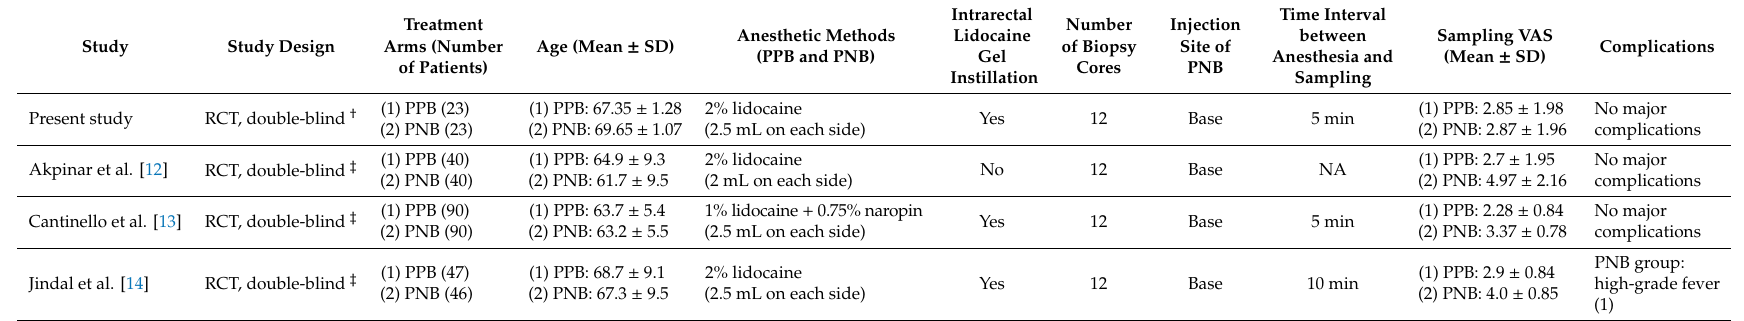
Table 3. Characteristics of the present study and previously published studies comparing PPB and